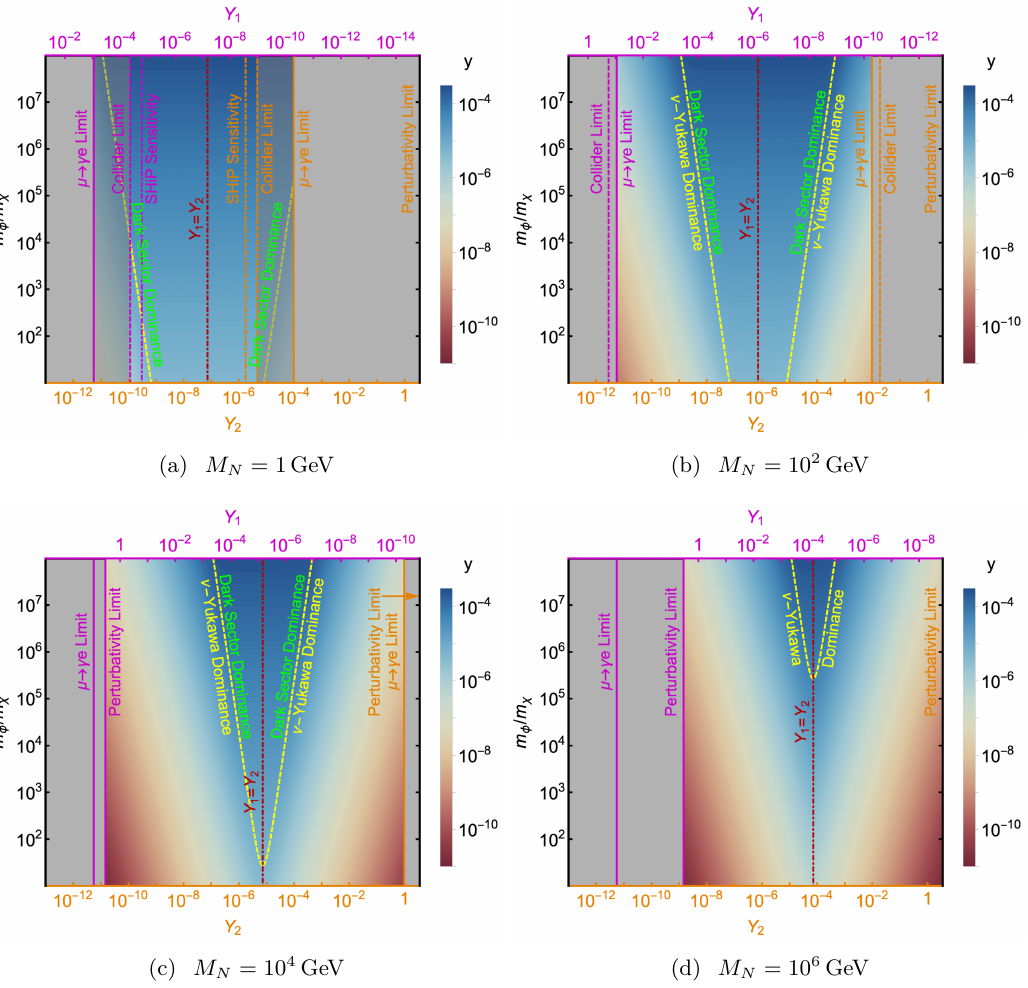
Figure 3 . Required portal coupling y in order to achieve the correct dark matter relic abundance in the m φ /m χ − Y 2 plane with different heavy neutrino mass. The reheating temperature is set to be T RH = 10 10 GeV and tan β = 10 to avoid gravitational effects [106]. m φ is fixed to be 10 8 GeV and m χ changes from 1 − 10 7 GeV. The relation between Y 1 and Y 2 is determined by eq. (2.17). The neutrino Yukawa process and dark sector process make equal contribution to the relic abundance along the yellow